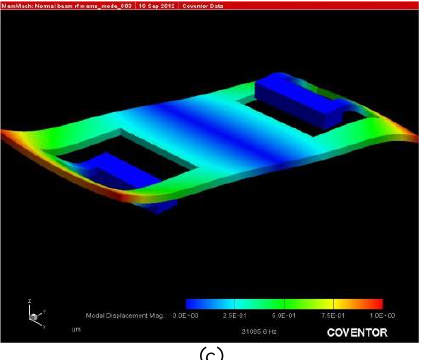
Figure 5. (a) Physical structure of MEMS switch with additional two short high impedance transmission lines. (b) Lumped electrical models of MEMS capacitive shunt switch for both up and down state. C u is 131 fF, C d is 3.5 pF, L is 4.3 pH and R is 0.04 Ω. (c) Comparing S 11 and S 21 for up and down state for both physical structure and electrical lumped model with EM3DS and Genesys.